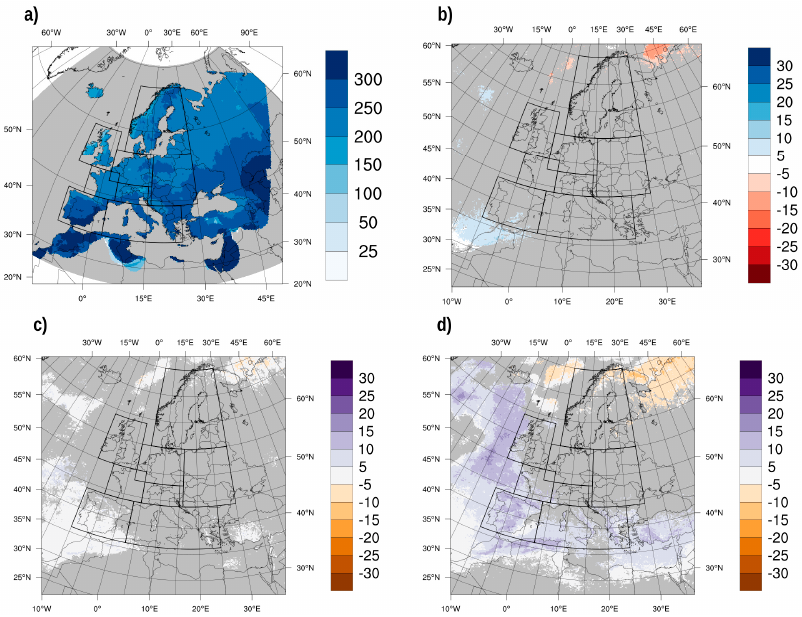
Figure 3. Same as Figure 1, but for dry days in days per year.